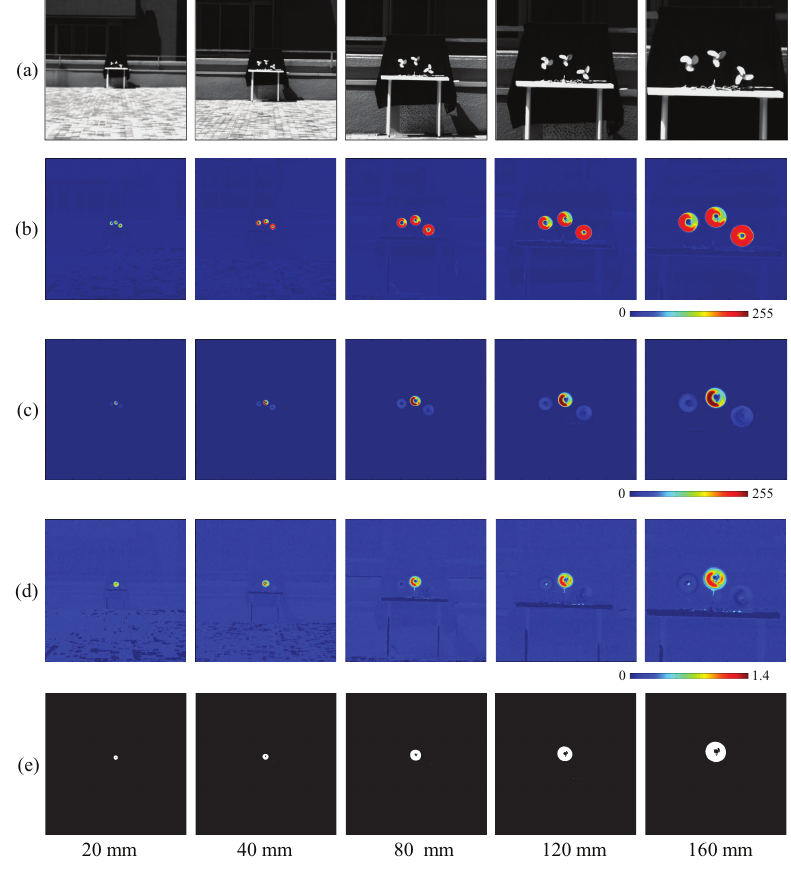
Figure 8. ( a ) Input images; amplitude of ( b ) input; and ( c ) pixel-wise filtered images; ( d ) amplitude ratios; ( e ) extracted vibration